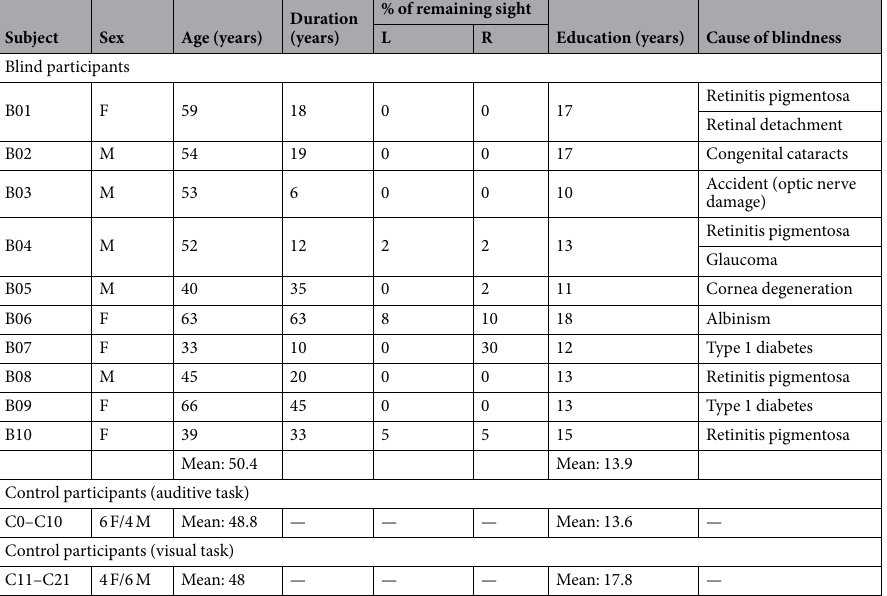
Table 1. The duration column represents the number of years that the participants have been blind. M = male; F = female, B = blind participants; C = control